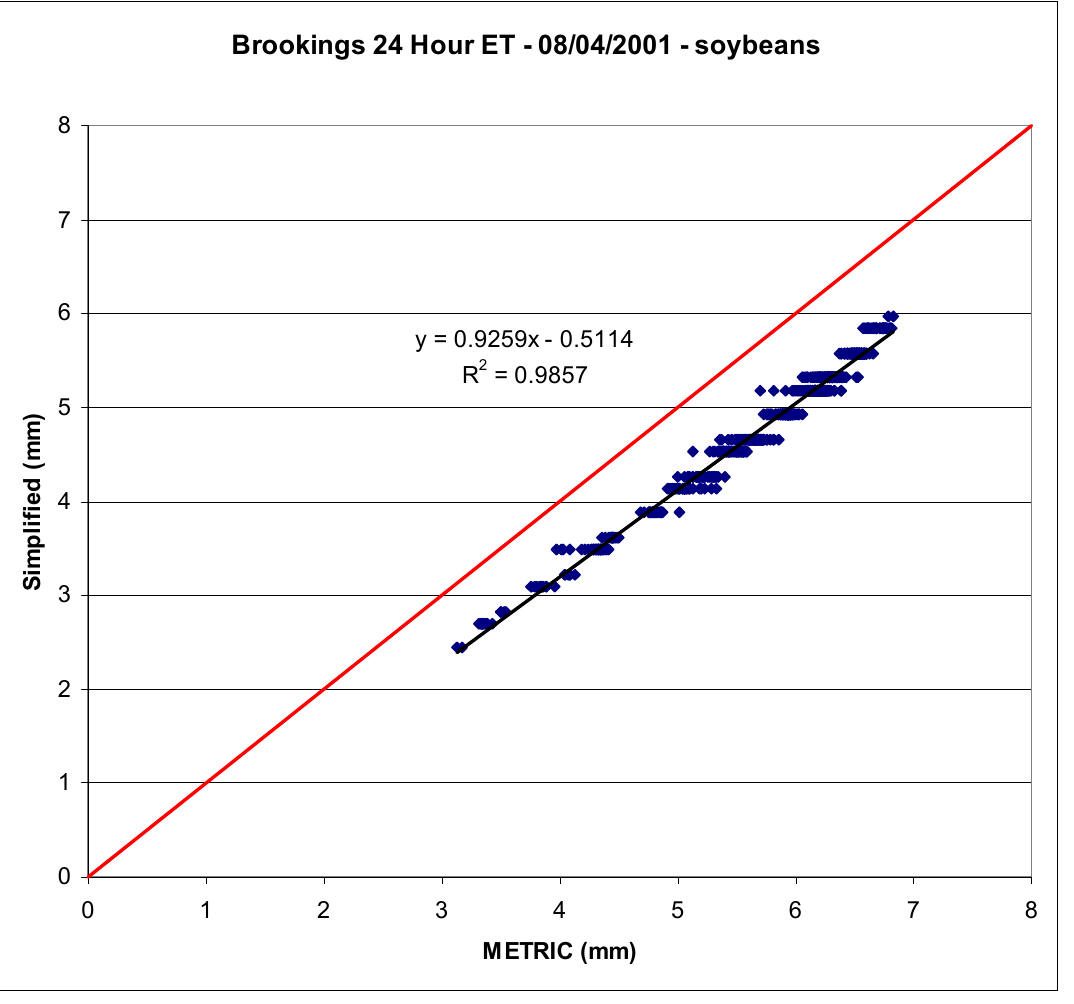
Figure 5. Scatter plot of one-day total actual ET (ETa) estimate between SSEB and METRIC model outputs in a soybean field on August 4, 2001. (Source: Swanson and Trooien,